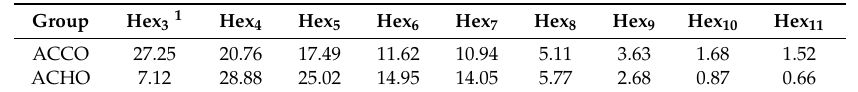
Table 1. Relative abundance (%) of each oligosaccharide in Antrodia cinnamomea (AC) polysaccharides at 90 ◦ C (ACHO) or 25 ◦ C